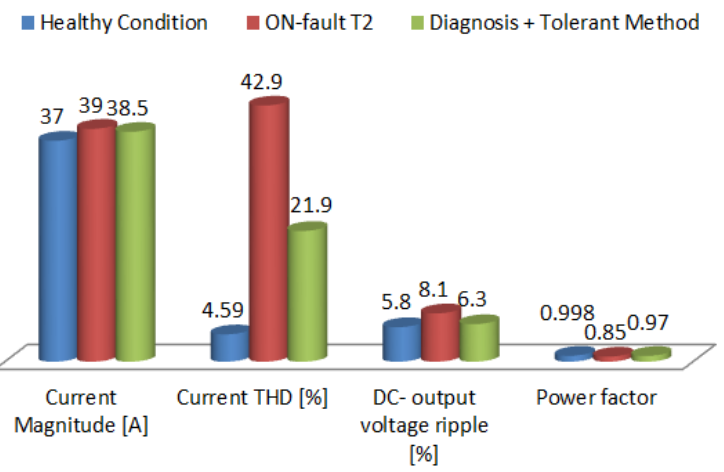
Figure 15. Theoretical results for three cases.